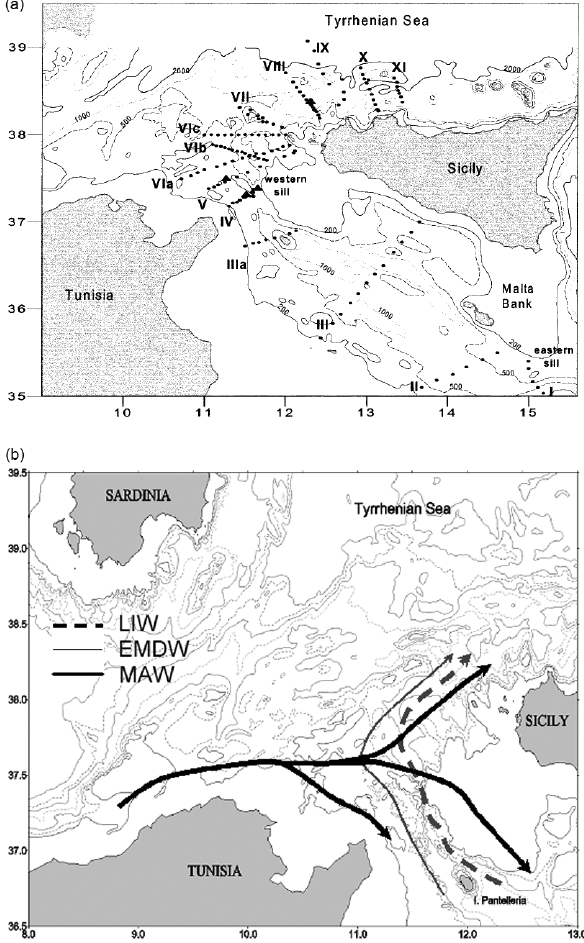
Figure 1. (a) General map of the Sicily Channel: the channel length is ∼ 500km, with two sills at its eastern and western entrances ( ∼ 550 and ∼ 350m deep, respectively). Dots indicate the hydro- graphic stations of all cross section vertical transects; triangles in- dicate the position of current-meter chains. The Ionian Sea is on the southeastern side of the map. From Astraldi et al. (2001). (b) Main routes of the principal water masses flowing through the region: LIW (Levantine Intermediate Water; dashed line), EMDW (Eastern Mediterranean Deep Water; solid line), and MAW (Modified At- lantic Water; bold line). The trajectory of the EMDW corresponds to the centerline of the vein in the different hydrographic sections. After Astraldi et al.